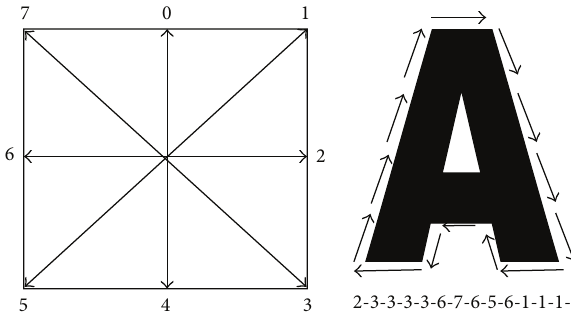
Figure 5: An example of 8-directional freeman chain code